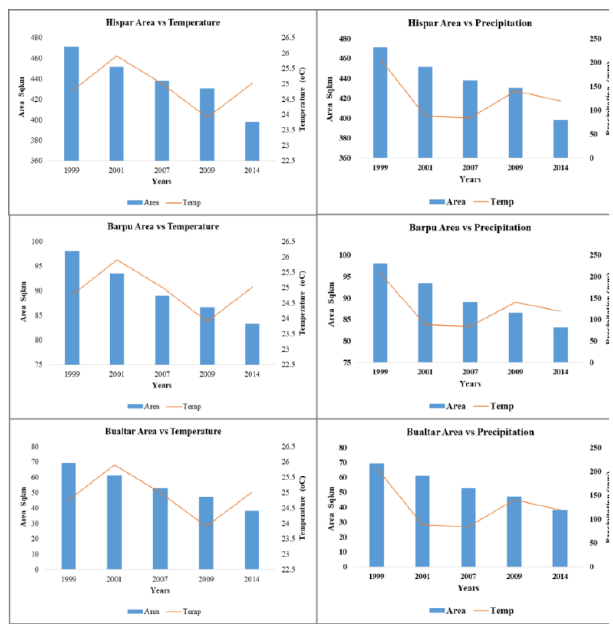
Figure 4: Influence of temperature and precipitation on glaciers